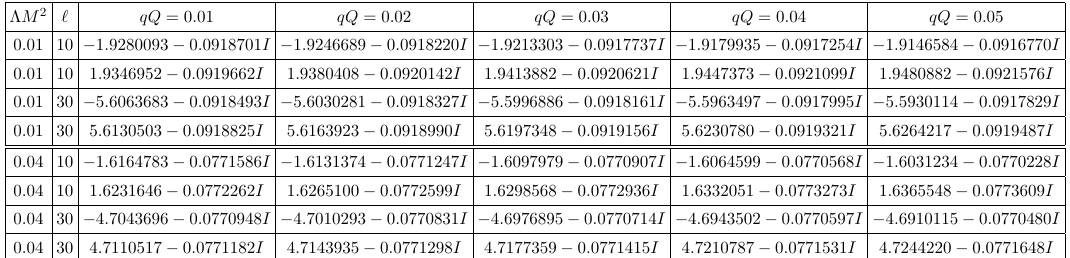
Table 8 . Photon sphere modes ωM ( n PS = 0 , 1 ) for massive scalar fields mM = 0 . 02 with ‘ = 10 , and 30 in the background of a RNdS black hole with different values of qQ